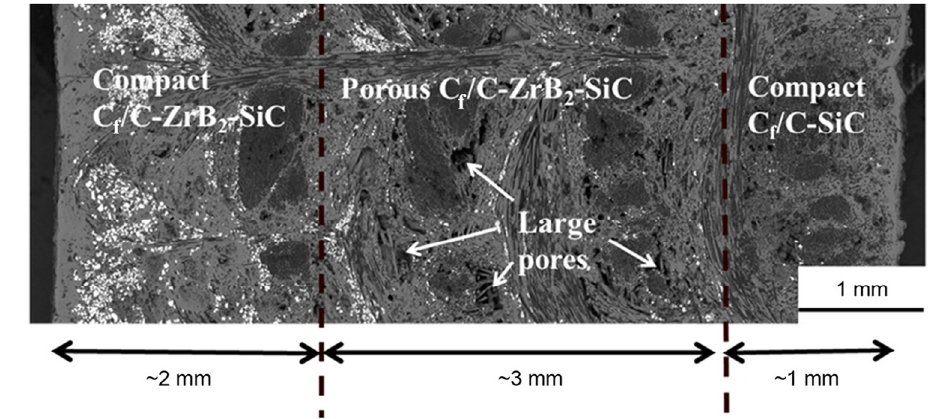
Figure 5: Back scattered electron image of the integrated composite [ 77 ]